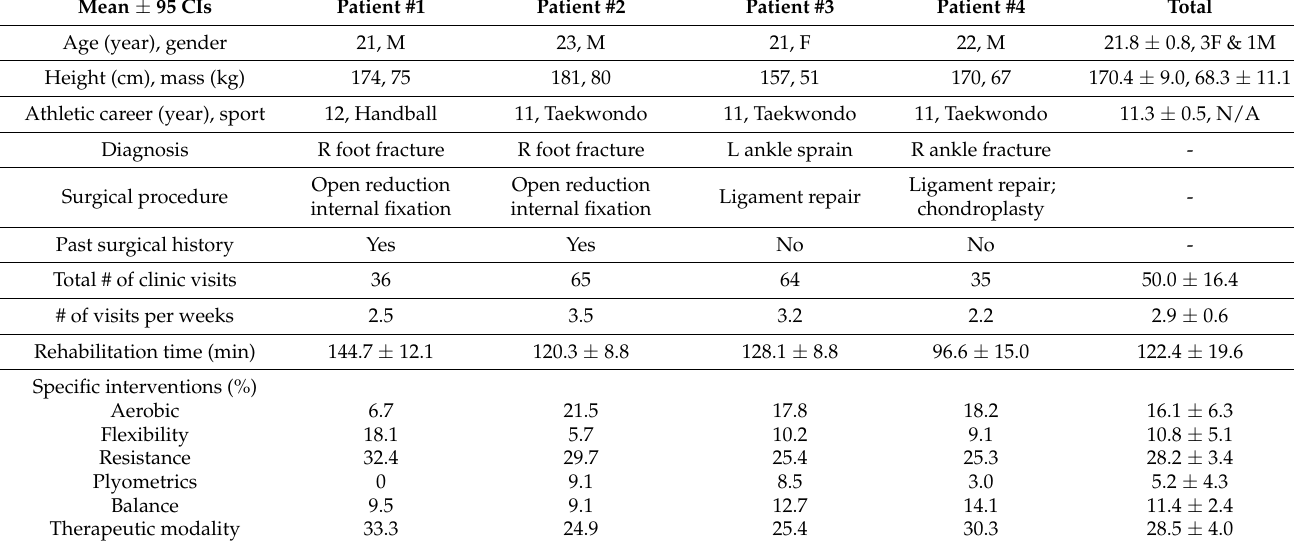
Table 1. Patient demographics, past medical history, and rehabilitation